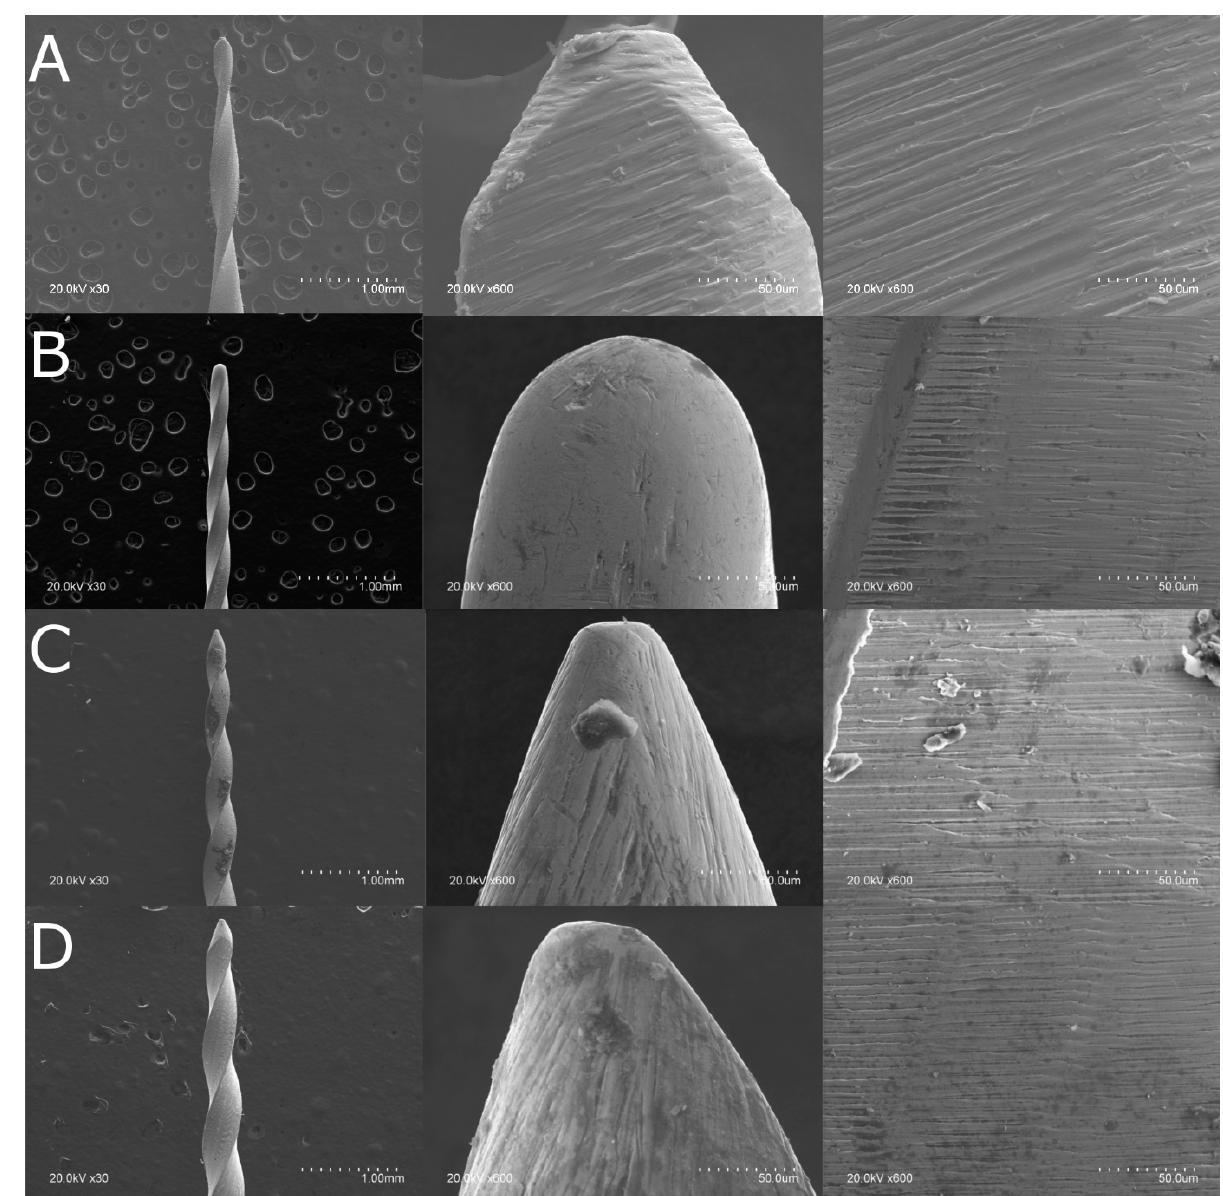
Figure 1. ( A ) SEM analysis of the Mtwo NiTi alloy endodontic rotary file, ( B ) T Pro E1 Gold-Wire NiTi alloy endodontic rotary file, ( C ) T Pro E2 Gold-Wire NiTi alloy endodontic rotary file, and ( D ) T Pro E4 Gold-Wire NiTi alloy endodontic rotary file.